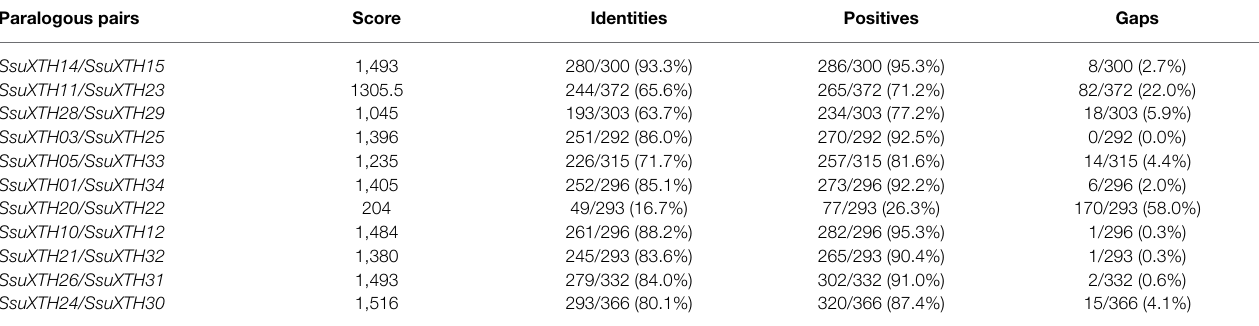
TABLE 2 | Sequence alignments of the 11 paralogous gene pairs of XTH genes in S. superba . Paralogous pairs Score